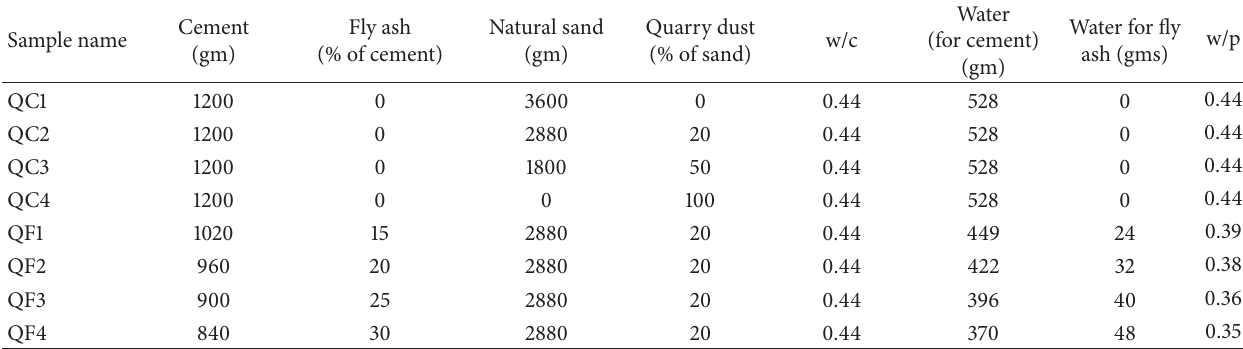
Table 7: Mix proportioning for 1 :3 mortar mixes.